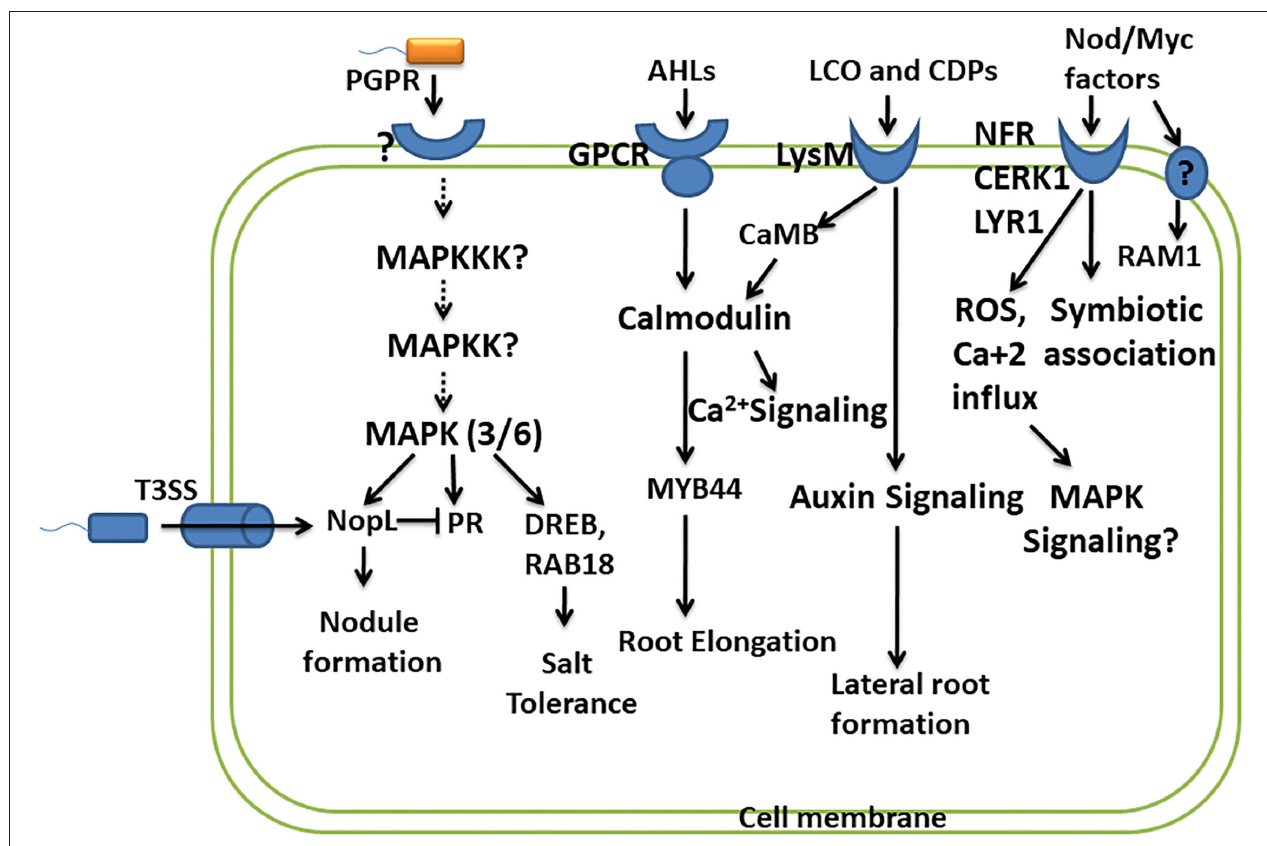
FIGURE 2 | Convergence of PGPR and plant signaling pathways. This depicts the studies carried out in understanding the signaling molecules/pathways involved in perceiving PGPR and their response in promoting plant growth and development. The important signaling pathways involved are MAPK signaling, calcium signaling, and hormone signaling. However, many other components of these pathways and their role in response to PGPR remain to be